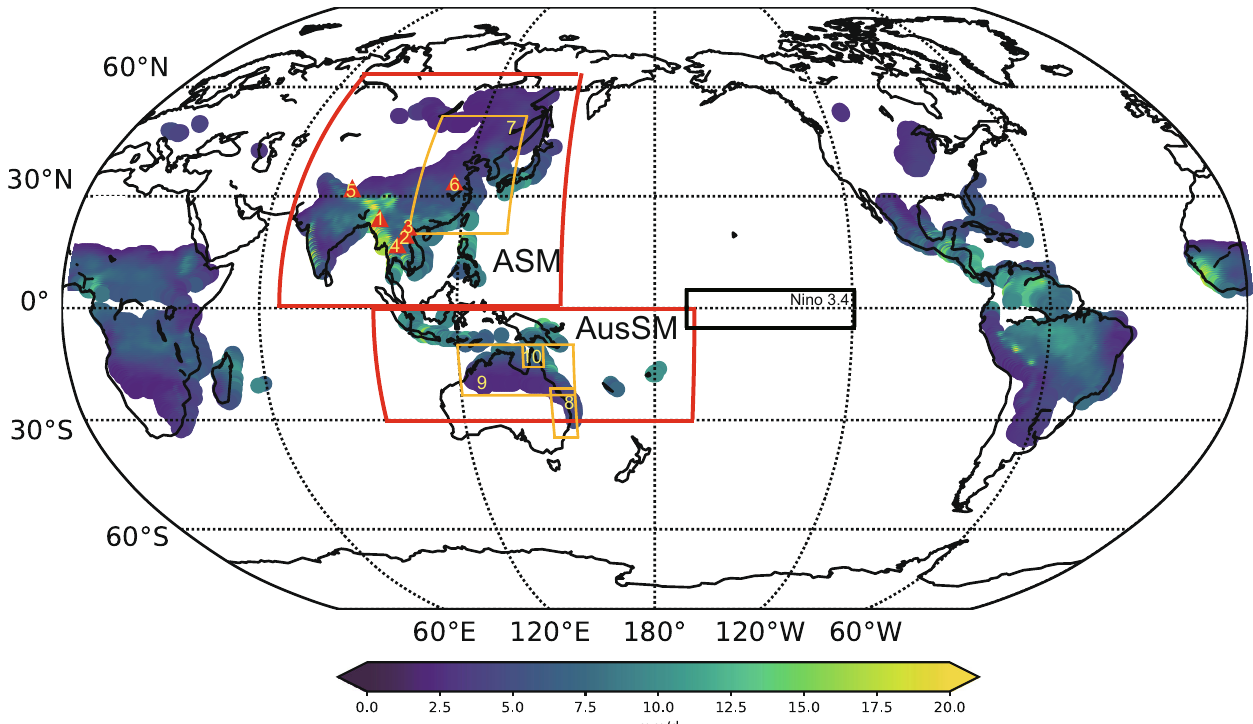
Fig. 1 Global monsoon domain and 10 records used for ASM and AusSM precipitation reconstruction. The global monsoon domain (shading area) which was calculated using precipitation data from CRU TS4.01 and GPCC 2018 during the period of 1901 – 2016 based on the de fi nition in the previous study 1 . Red boxes indicate ASM and AusSM domain. Location of the 10 records (red triangles and orange boxes) for ASM and AusSM precipitation reconstruction. Red triangles indicate the tree ring oxygen isotope chronologies and orange boxes indicate regional precipitation reconstruction in previous study; black box indicates Niño 3.4